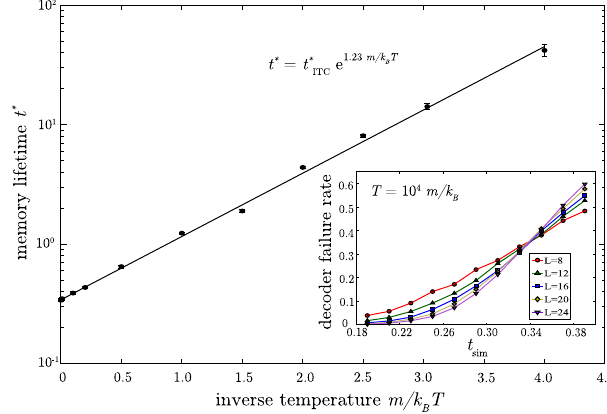
FIG. 9. Memory lifetime t (cid:5) scales exponentially with the 0 . 343 e 1 . 23 m=k B T . inverse temperature. The linear fit is t mem ¼ Inset: Thermal simulations used to determine the memory life- ≈ 0 . 343 of the system at temperature T ¼ 10 4 m=k time t (cid:5) B . ITC Similar simulations (with L ¼ 20 , 16, 12, and 8) were performed for different values of T ¼ 10 4 , 100, 10, 5, 2, 1, 0.75, 0.5, 0.4, 0.33, and 0.25 to determine the memory lifetime as a function of